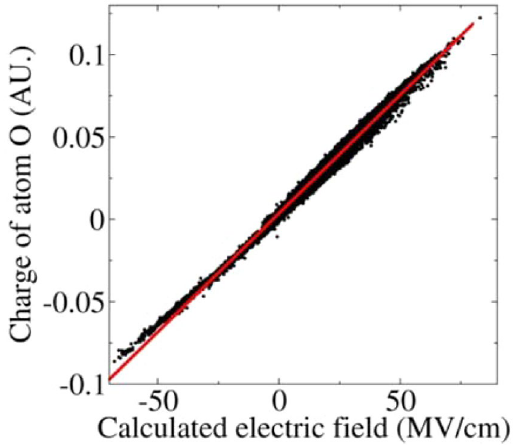
Figure 6. The obtained ESP charges in the O atom of the CO molecule derived from the QM/MM calculations in the MD simulation as a function of the electric fields along the CO bond, which exhibits a linear function relationship. The influence of the changes in the bond length of the CO was